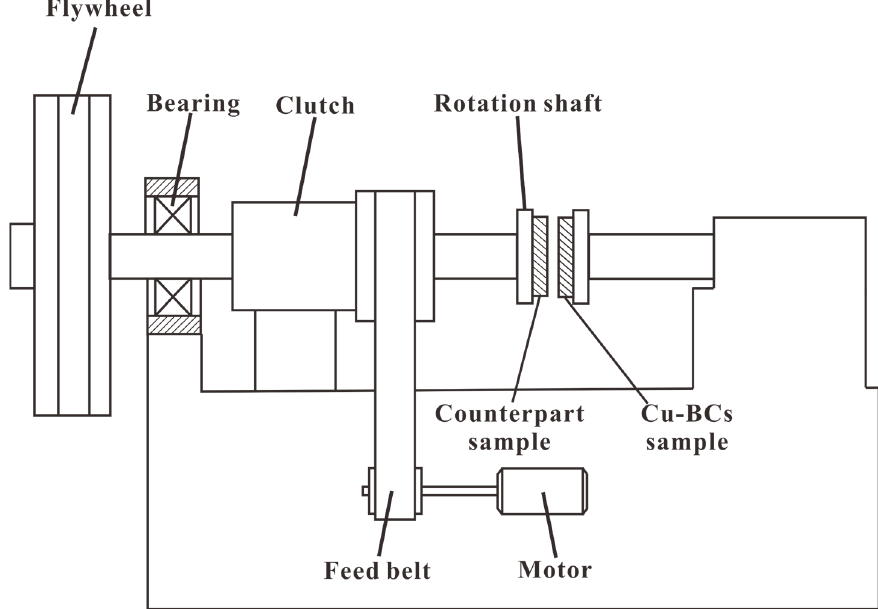
Figure 2. Structure chart of the MM-3000 friction tester.